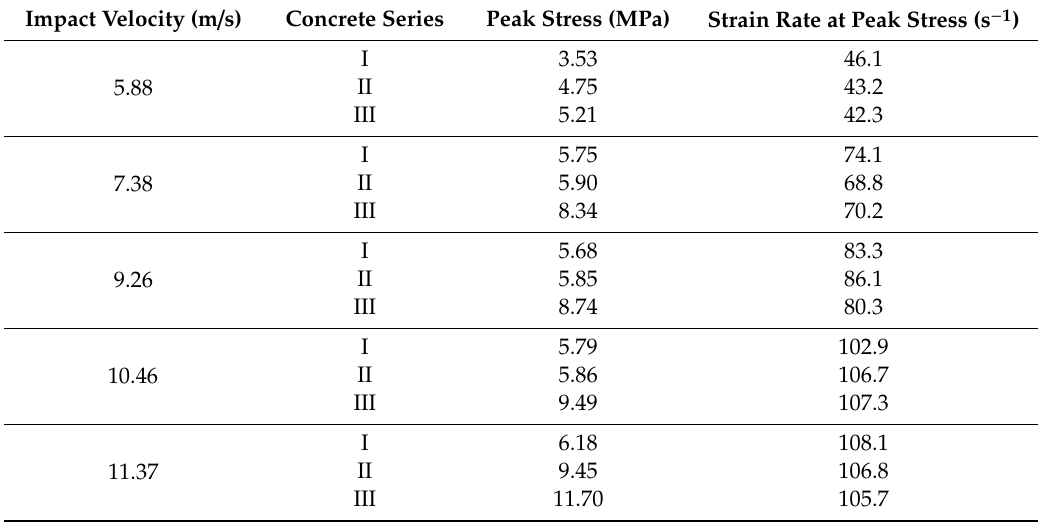
Table 6. Dynamic properties of three series of concrete specimens under different impact velocities. Impact Velocity